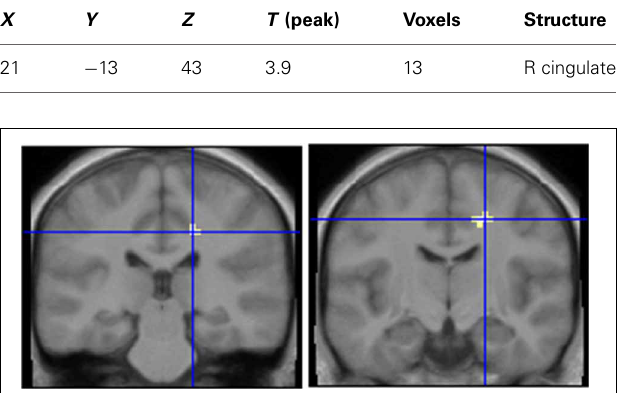
Table 3 | Specific brain activations following ambroxan stimulation between subjects who perceive ambroxan (SEN) and those who don’t (INS); contrast: AMB [SEN] vs. AMB [INS] ( p < 0 . 001; uncorrected).